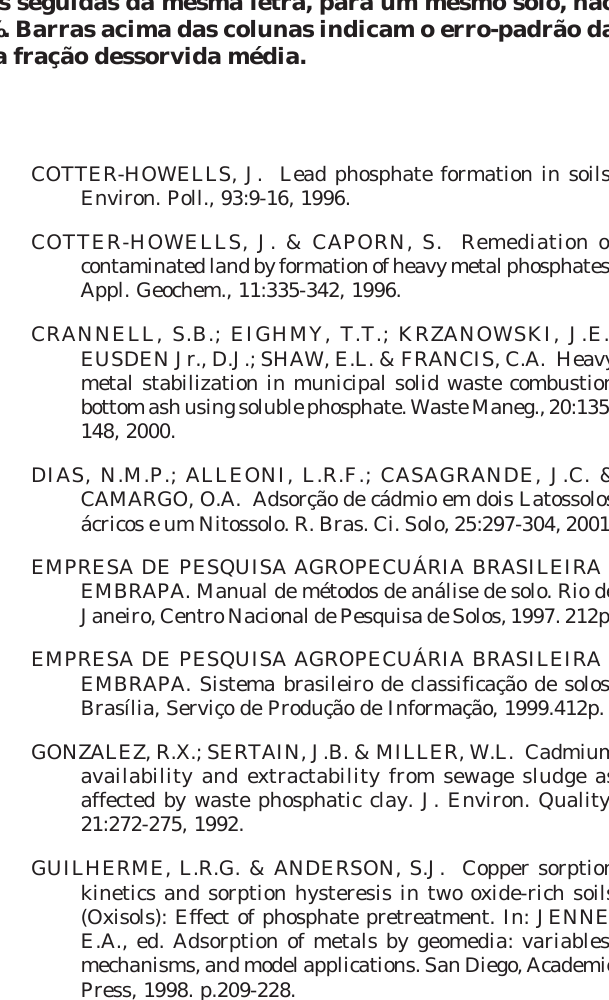
/Metal ), por Ca(NO ) 5 mmol L -1 , dos metais Pb e Cu, dessorvido adsorvido 3 2 ) , Cu(NO ) e Pb(NO ) 0,45 mmol L -1 (LVAw = Latossolo Vermelho- 3 2 3 2 3 2